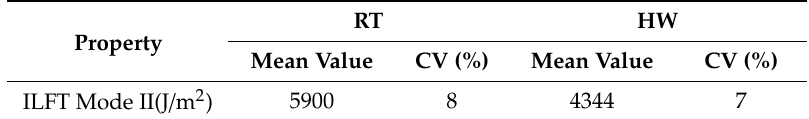
Table 11. E ff ect of hot-wet storage aging on interlaminar fracture toughness in Mode